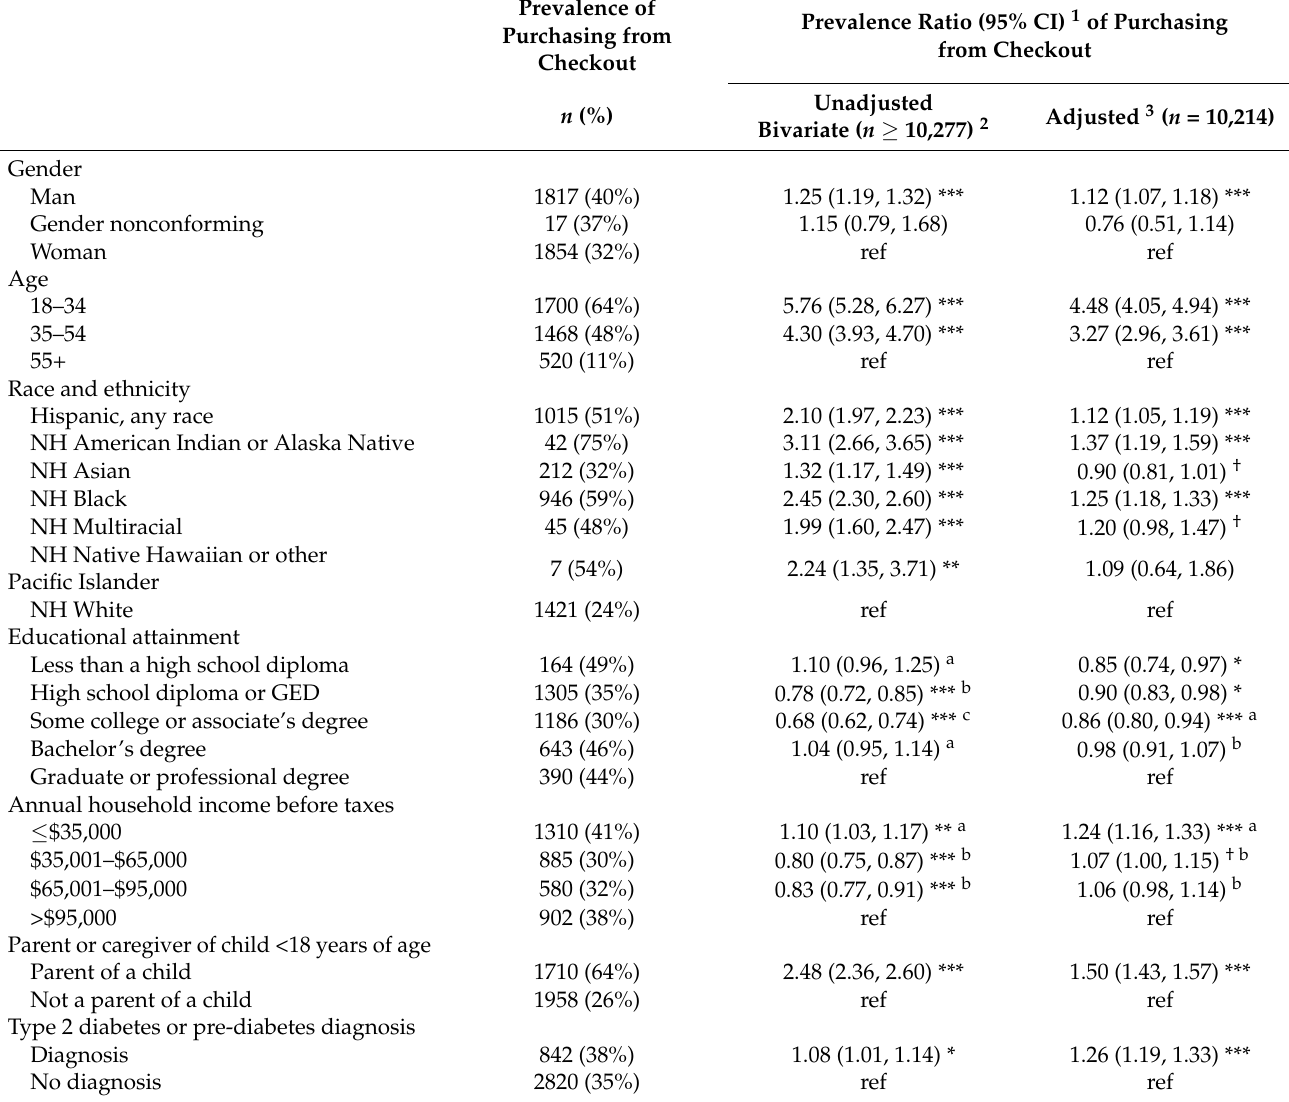
Table 3. Prevalence and prevalence ratios of purchasing foods or drinks found in the checkout area (i.e., from checkout) during the last grocery shopping trip by sociodemographic